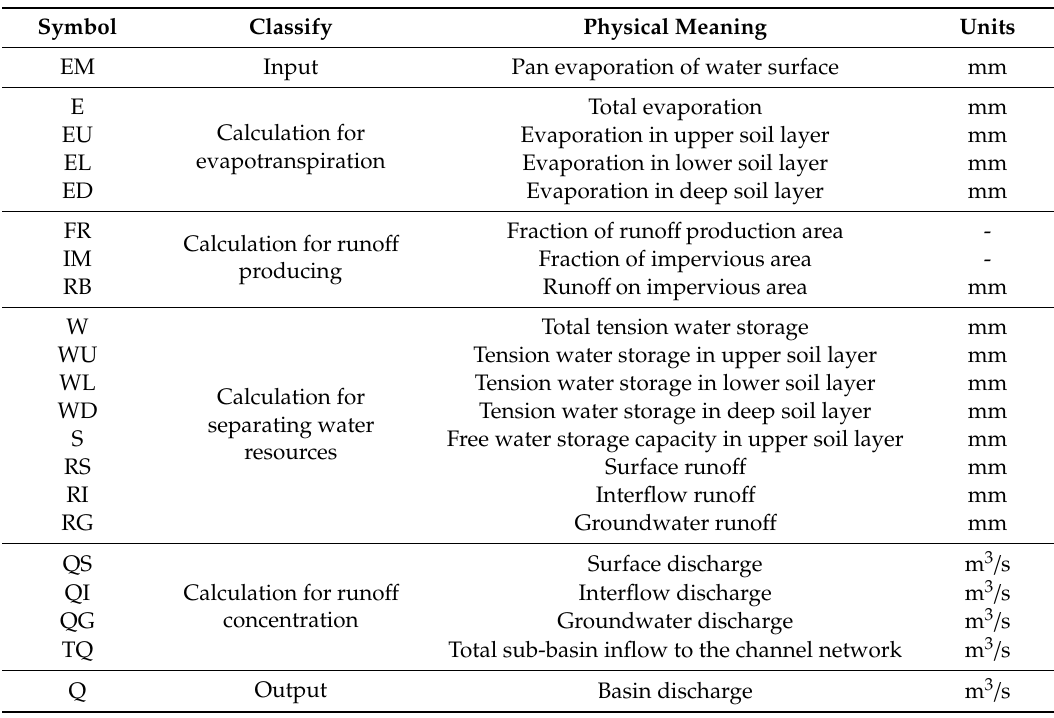
Table 4. State variables in Xinanjiang